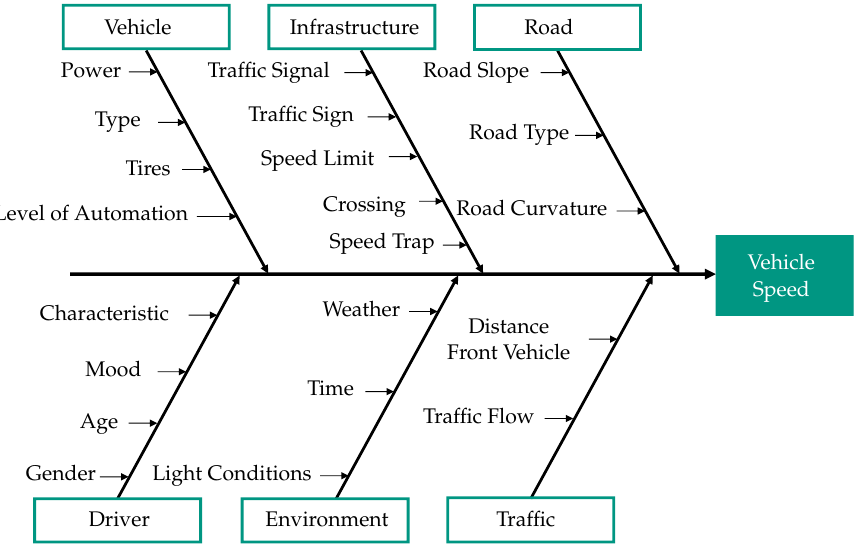
Figure 1. Overview of influences on the driving profile based on related work as a sequence of traffic events. Based on this, the route is divided into segments of equal 91 maximum velocity. Transitions between the segments are described with acceleration 92 phases or braking phases. Such prediction can be made for the entire route, as it is based 93 only on stationary traffic events. A disadvantage of this method is that it is difficult to 94 take into account spontaneous traffic events such as congestion or temporal variations 95 in traffic density. 96